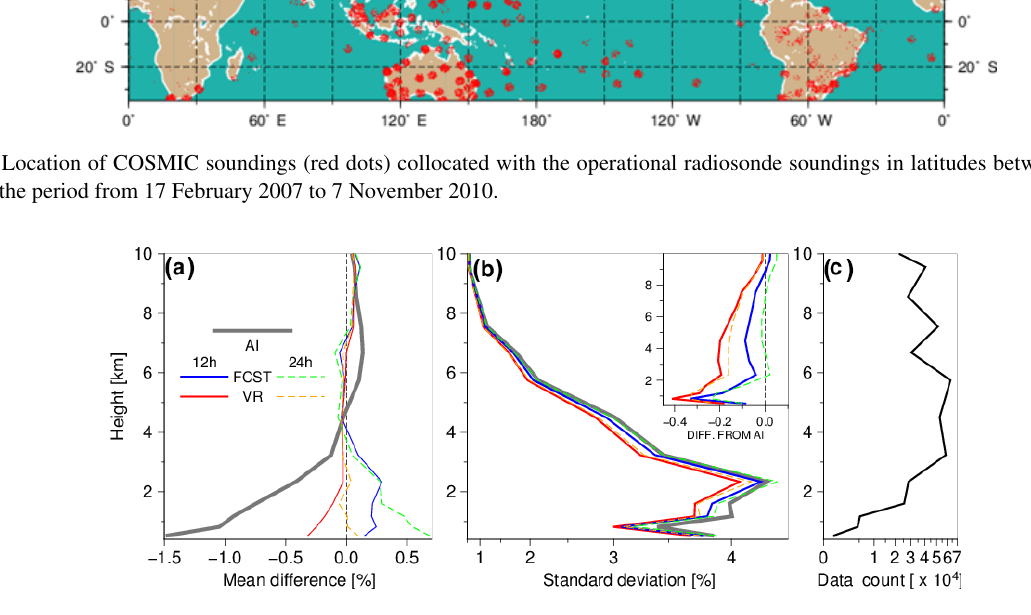
Figure 10. Comparison with collocated operational radiosonde data (ORD). (a) Mean difference from ORD of CDAAC’s refractivity derived via Abel inversion (thick dark grey line, denoted AI), ECMWF’s 12h forecast (solid blue) and 24h forecast (dashed green), and VR-produced refractivity for which 12 (solid red) or 24h (dashed gold) forecast is used as the background. The unit used here is %, i.e., the percentage with respect to the mean value of ORD. (b) Same as in panel (a) except for the standard deviation. The inset shows the difference from AI in the standard deviation from ORD. (c) Number of samples used in the comparison. Note that scales of the x axis in panel (b) and (c) are not